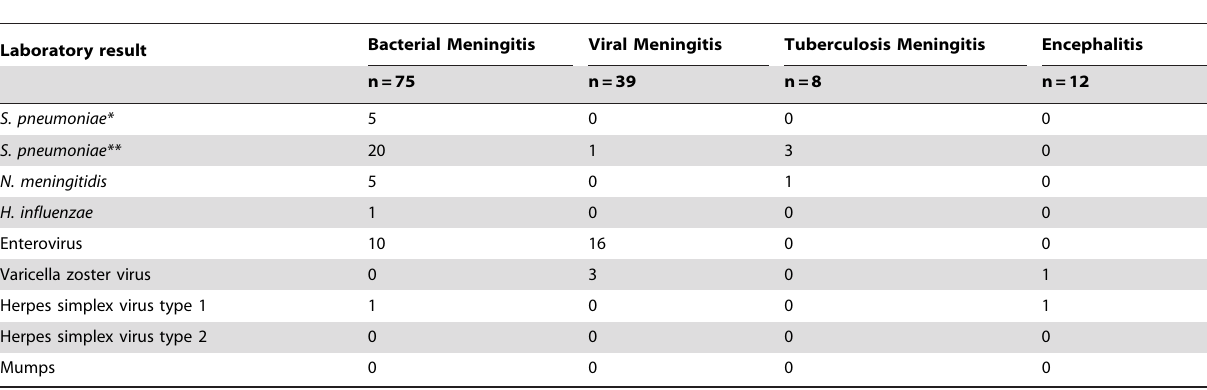
Table 5. Laboratory results for patients diagnosed with bacterial meningitis, viral meningitis, TB meningitis, and encephalitis, country of